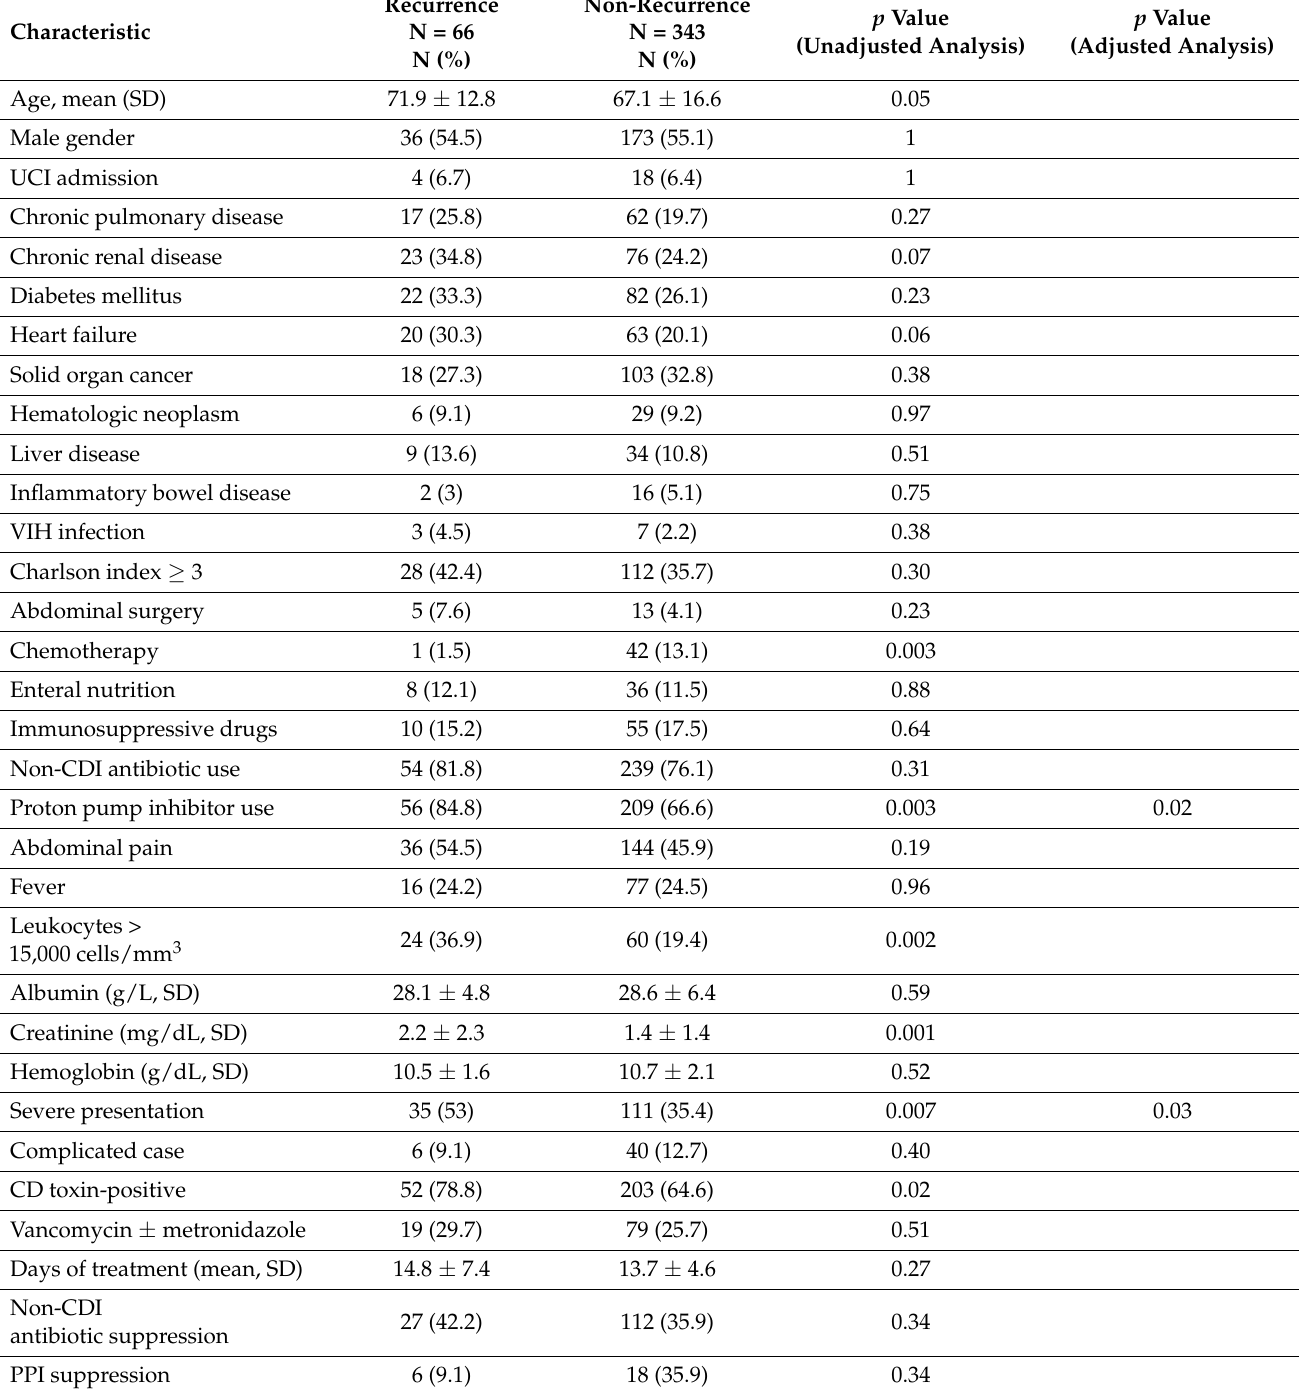
Table 4. Univariate and multivariate predictors of